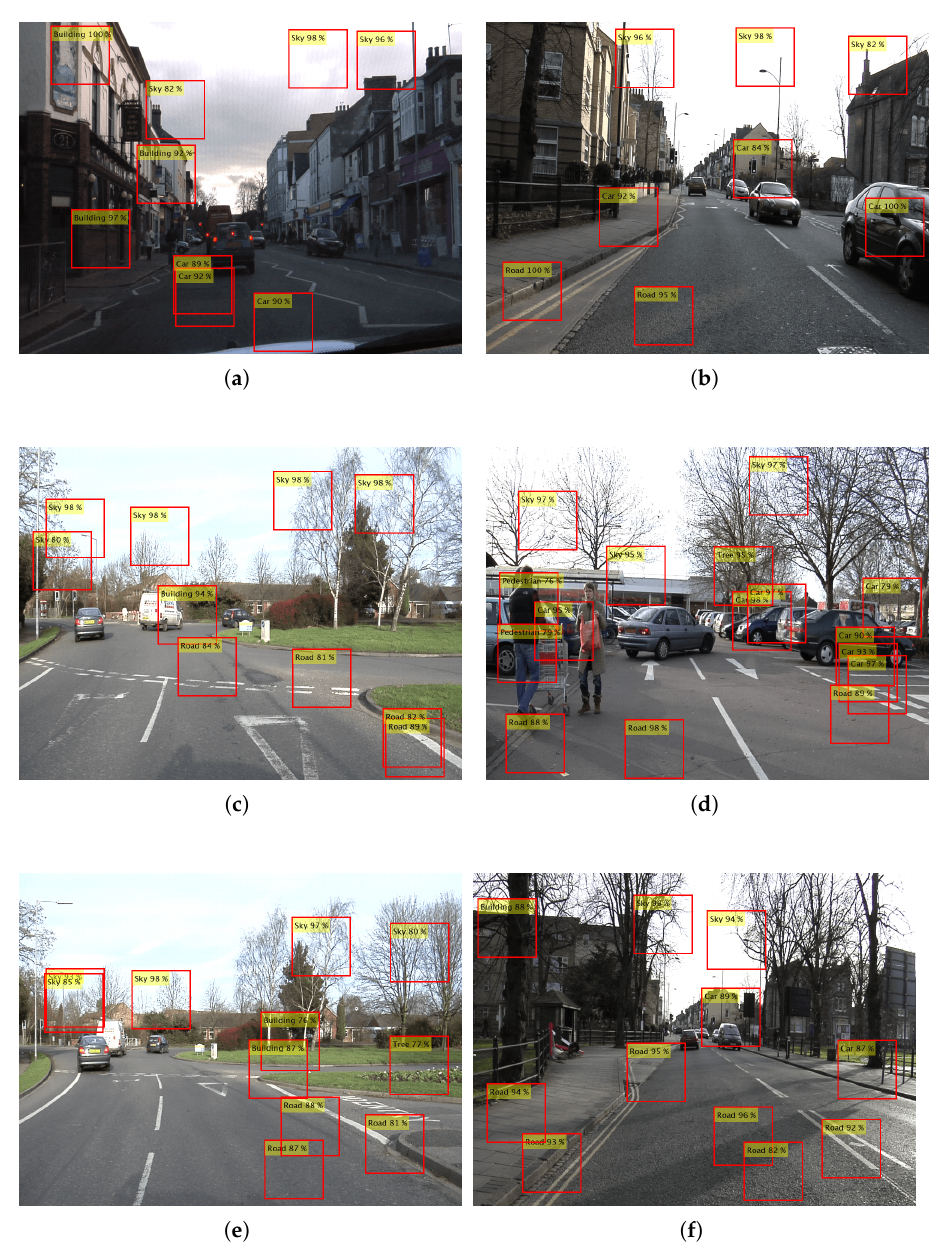
Figure 12. Classification of objects using CamVid. ( a ) Test image #1. ( b ) Test image #2. ( c ) Test image